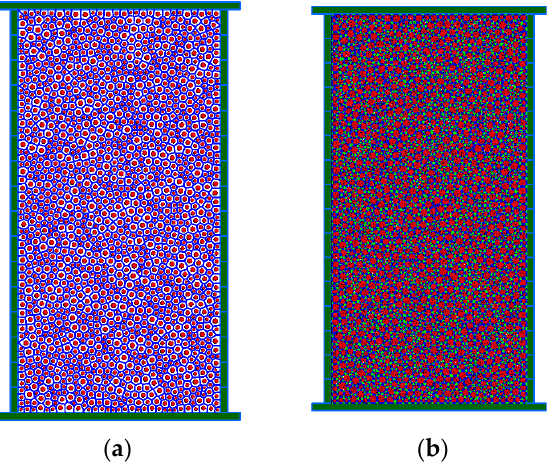
Figure 6. Rigid PM models boundary conditions through rigid plates: ( a ) rigid PM model; ( b ) grain